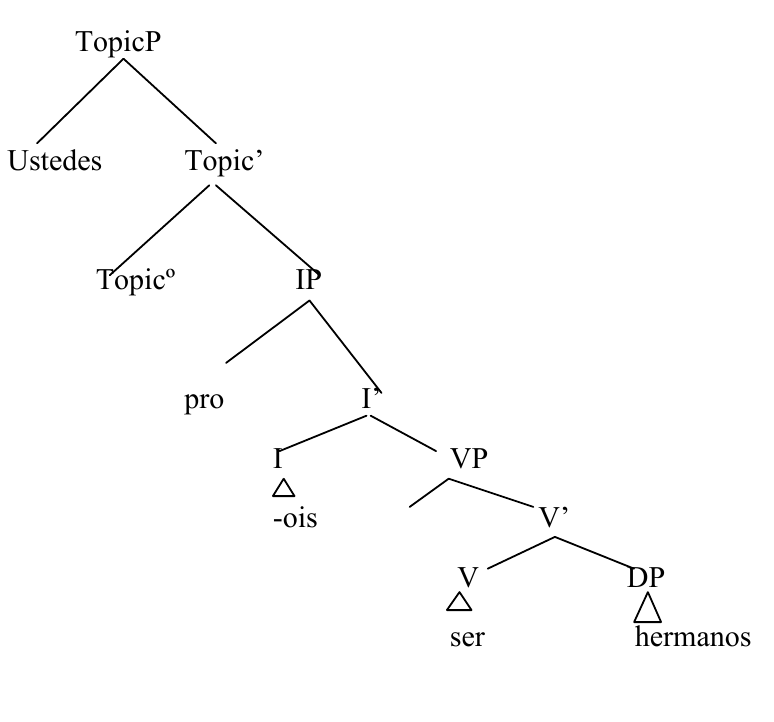
Graphic 1: Representation of ustedes [pro